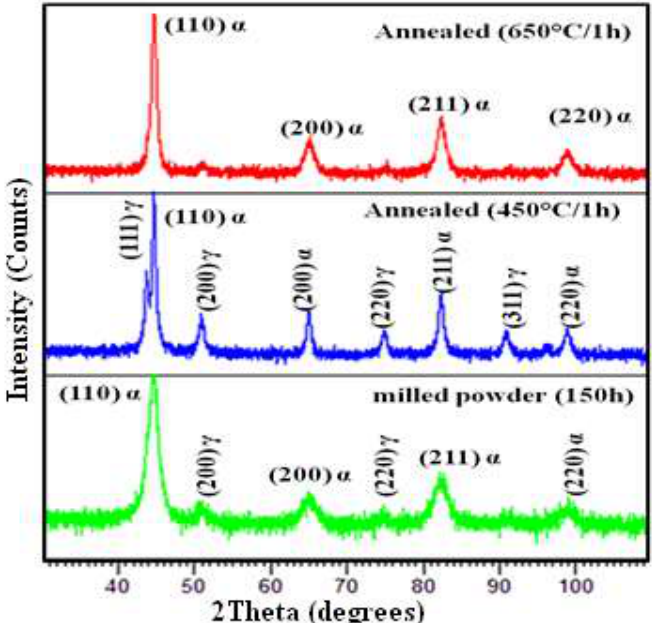
Figure 8. X-ray diffraction patterns of MA Fe 70 Ni 12 B 16 Si 2 powders for 150 h of milling obtained after annealing at 450 °C and 650 °C.